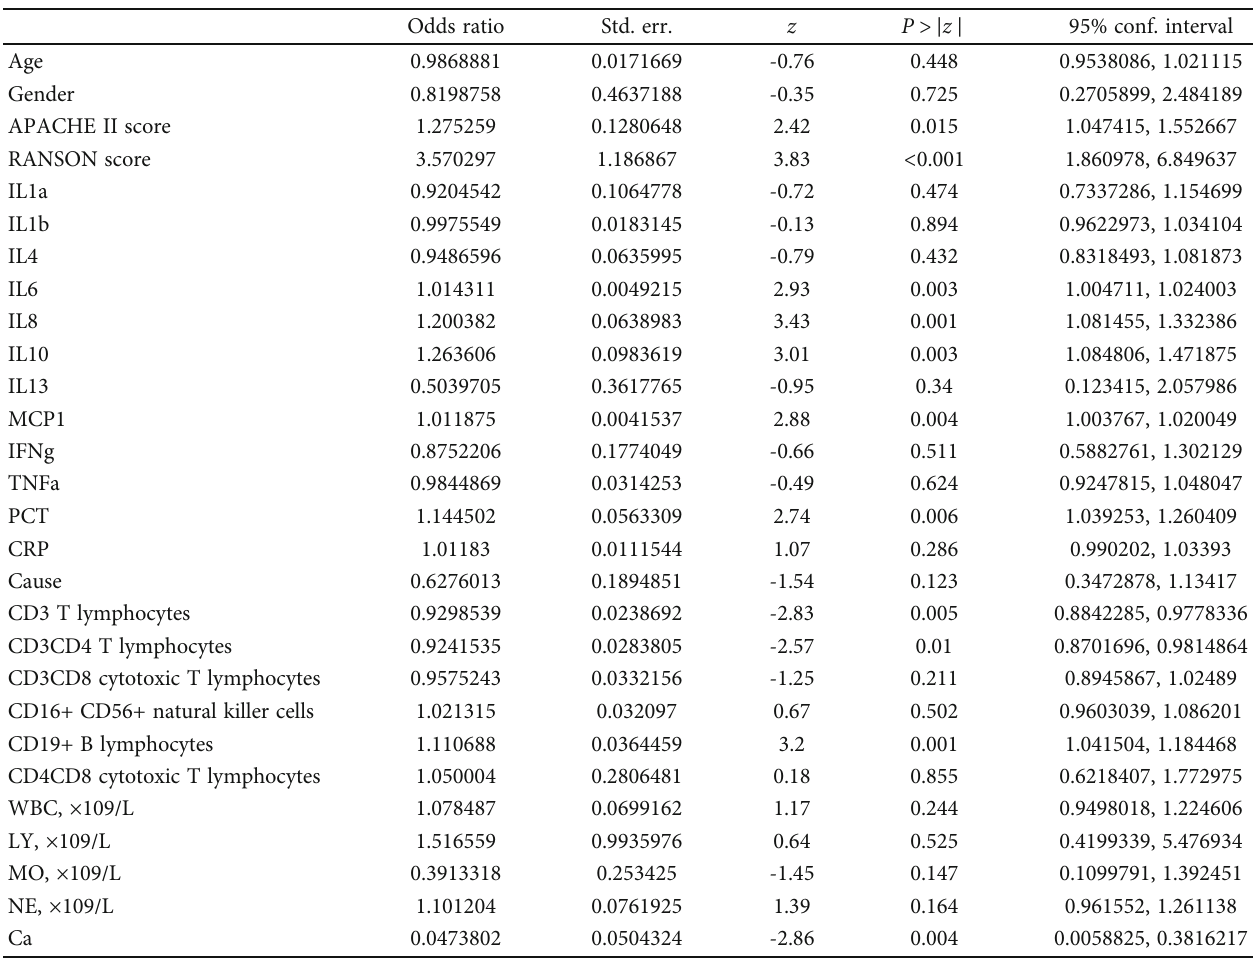
Table 3: Univariate analyses of factors predicting OF. Odds ratio